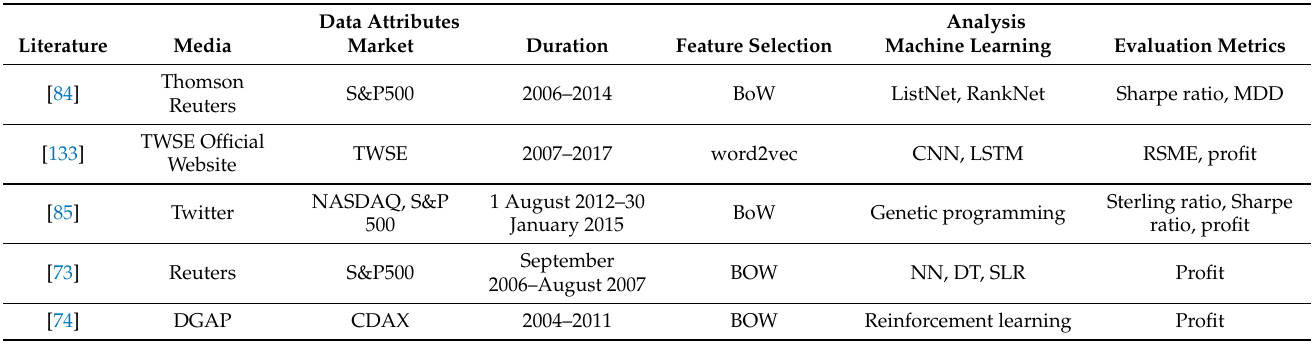
Table 7. Comparison of trading strategies